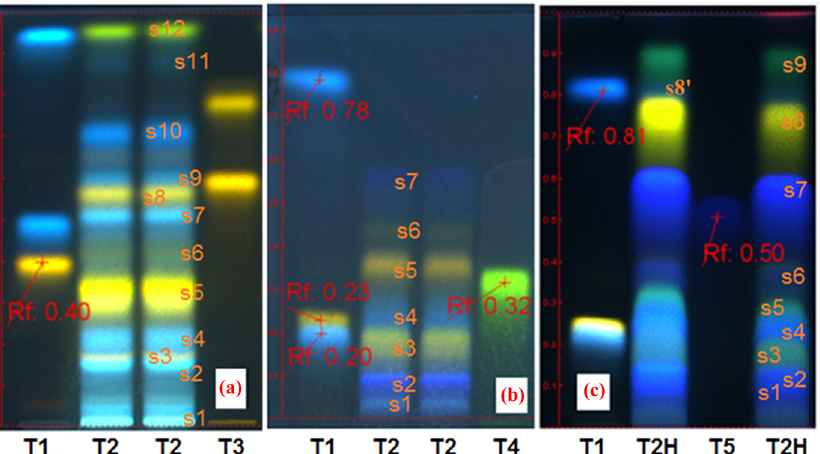
Figure 3: ( HP ) TLC studies of the G. pratense ethanolic extract ( Gpre36 ) . Chromatogram A ( system a ) – track T1, rutin, chlorogenic acid and ca ff eic acid ( ref. ) ; tracks T2, ethanolic extract from G. pratens e ( Gpre36 ) ; track T3, quercitrin - 3 - O - glucoside/isoquercitrin and quercitrin - 3 - O - rhamnoside/quercitrin ( ref. ) ; chromatogram B ( system b ) – track T1, rutin, chlorogenic acid and ca ff eic acid ( ref. ) ; tracks T2 – ethanolic extract from G. pratens e ( Gpre36 ) ; track T4, luteolin - 8 - C - glucoside/orientin ( ref. ) ; chromatogram C ( system c ) – track T1, rutin, chlorogenic acid and ca ff eic acid ( ref. ) ; track T2H, the hydrolyzed extract from ethanolic extract Gpre36; track T5, gallic acid ( ref. )